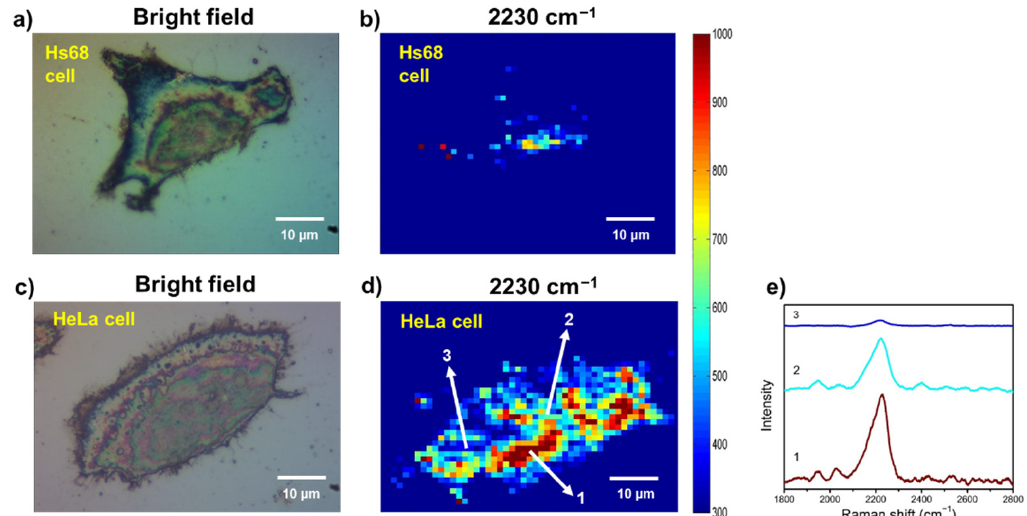
Figure 6. SA expression on the surface of single Hs68 cell and HeLa cell that were pretreated with nanoprobe. Bright-field ( a , c ) and SERS mapping ( b , d ) images of Hs68 cell and HeLa cell, respectively, were generated by the excitation with 532 nm laser (0.78 mW, 100× objective lens, exposure time of 1 s, and step size 1 µm). ( e ) SERS spectra corresponding to points 1–3 were produced by the SERS mapping image of HeLa cell ( d ).